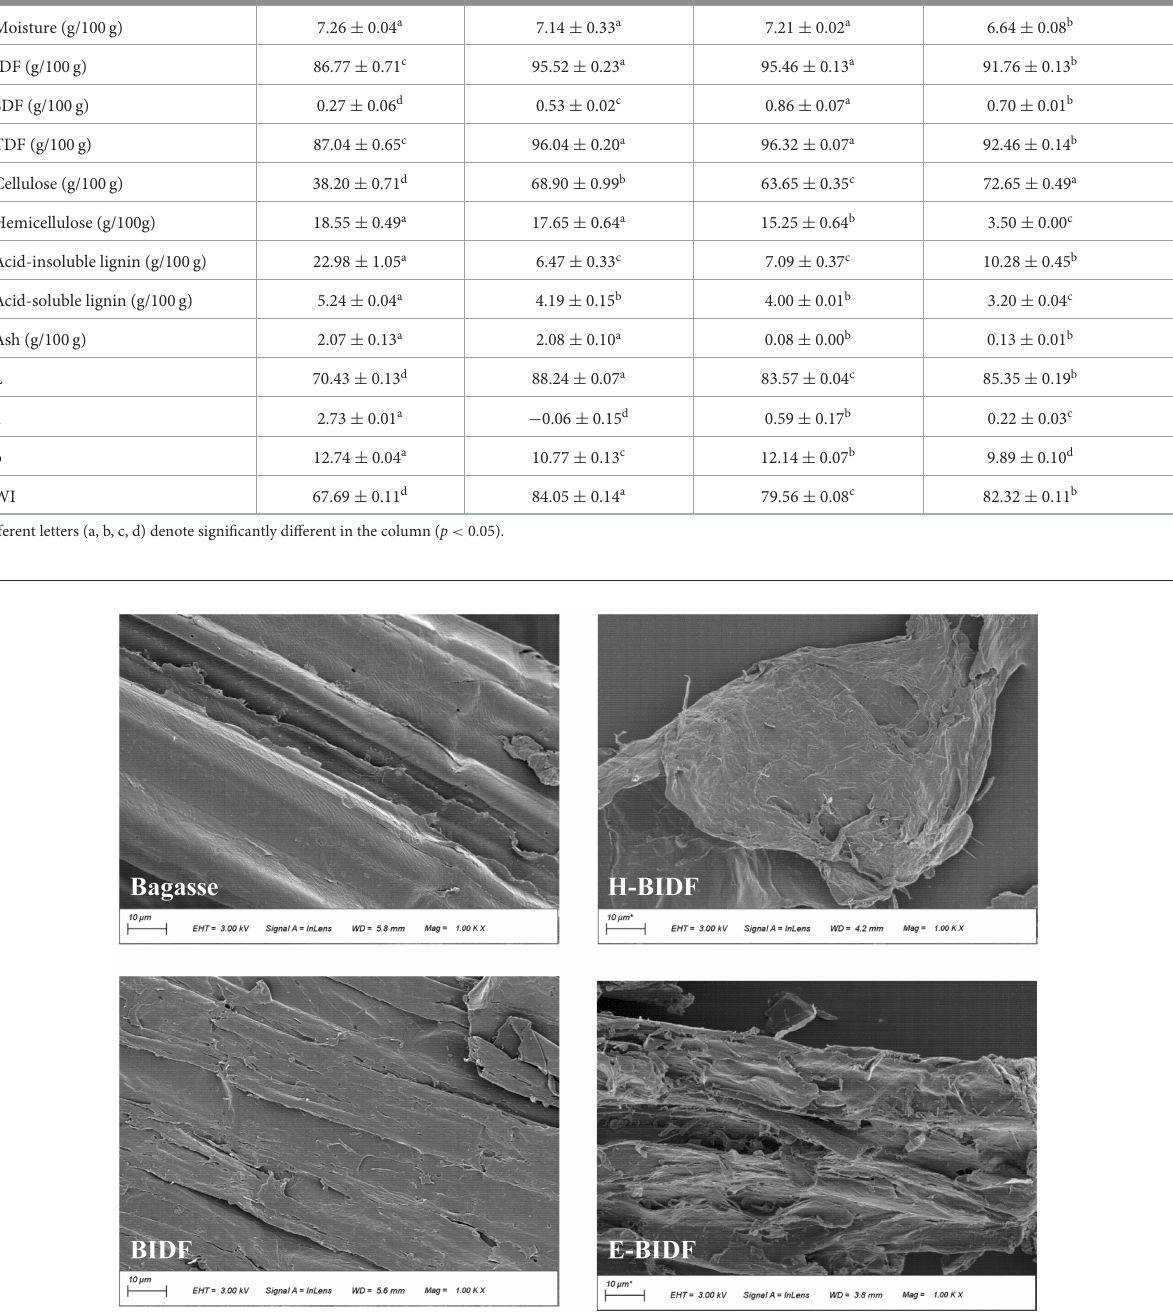
by the AHP process, in addition to the possibility that the combined HTPC treatment disrupted the intermolecular forces of